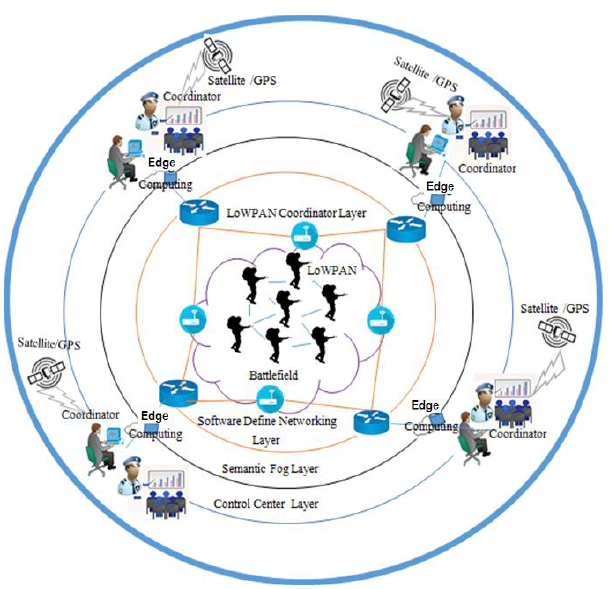
Fig.1. WSN/ IoT architecture for military